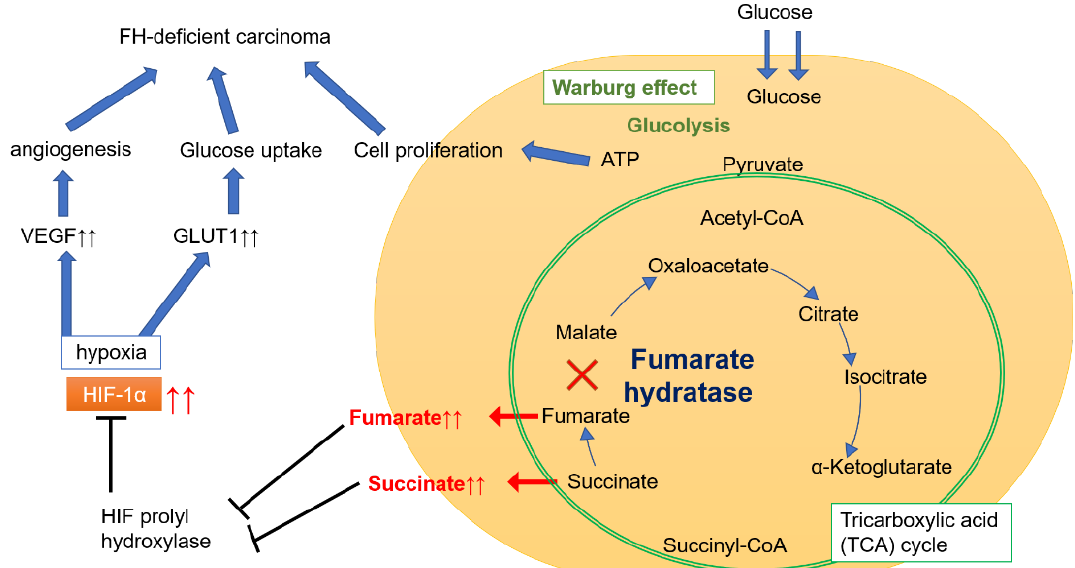
Figure 1. Energy metabolism pathway in FH-deficient carcinoma. Fumarate hydratase (FH) is an enzyme that converts fumarate to malate in the tricarboxylic acid (TCA) cycle in mitochondria. When FH malfunctions, fumarate and succinate accumulate, resulting in prolyl hydroxylate inhibition and consequent hypoxia-inducible factor 1-alpha (HIF-1 α ) stabi- lization. Accumulation of HIF-1 α leads to the upregulation of vascular endothelial growth factor (VEGF) and glucose transporter 1 (GLUT1). VEGF promotes angiogenesis, while GLUT1 promotes glucose uptake and contributes to the etiology of high-grade FH-deficient carcinoma. In cancer cells, oxidative phosphorylation is impaired, and aerobic glycolysis (known as the Warburg effect) becomes the primary energy production mechanism. As glycolysis progresses, adenosine triphosphate (ATP) production increases, prompting cell proliferation. In FH-deficient carcinoma, the proliferation of highly malignant cancer cells depends on these